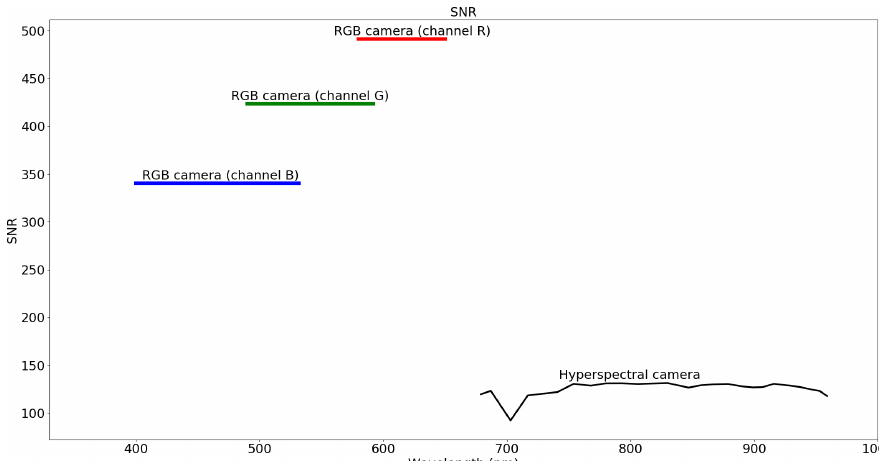
Figure 4. SNR values of each spectral channel of the RGB and hyperspectral cameras.